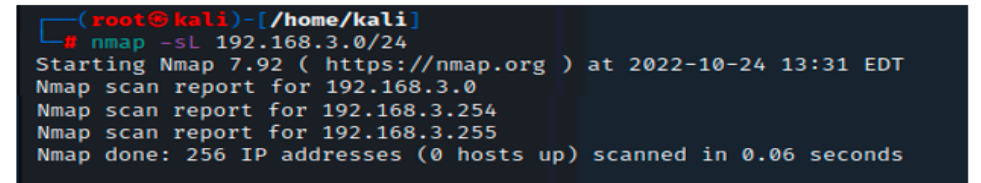
Figure 1. Nmap scan with -sL command.